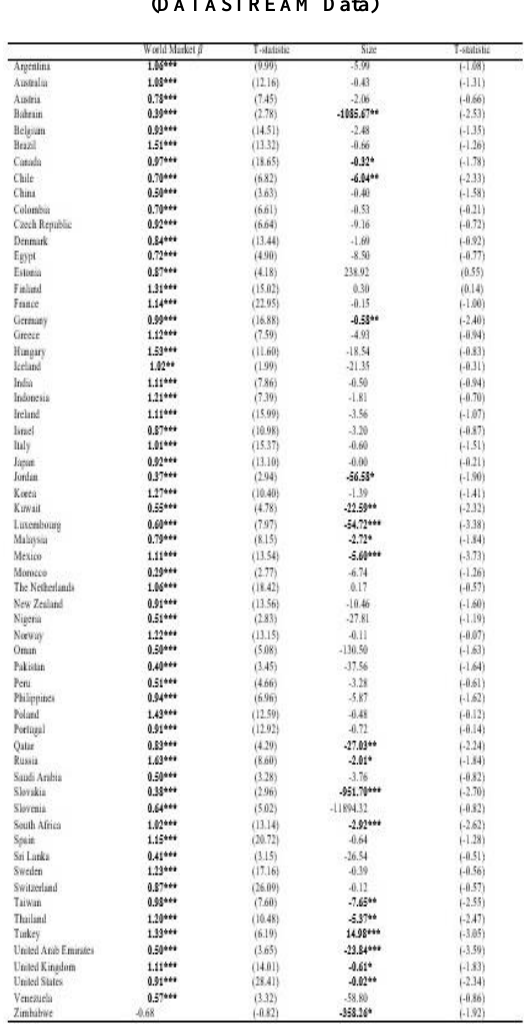
Table 4: Size Effects, Time Series